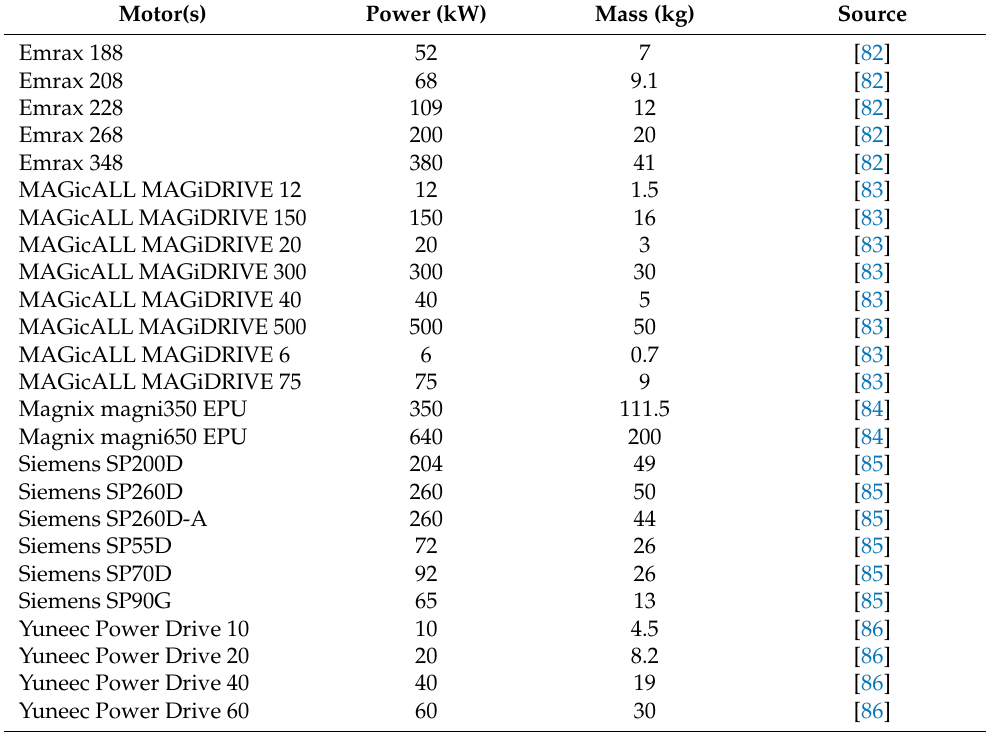
Table A2. Electric motor performance